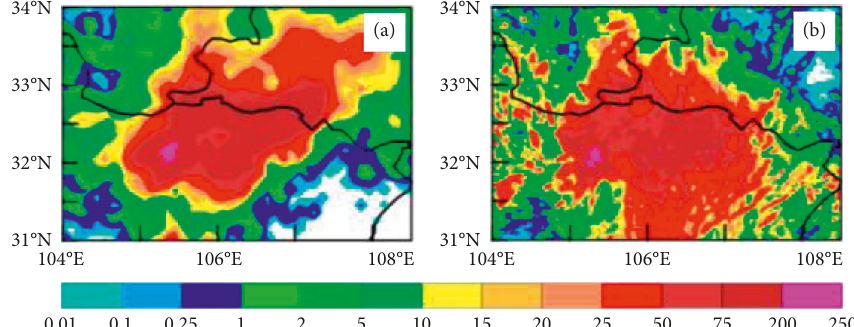
Figure 2: Twenty-four-hour accumulative precipitation from 06:00 UTC on June 27 to 06:00 UTC on June 28, 2015: (a) observation data; (b) simulation result (unit: